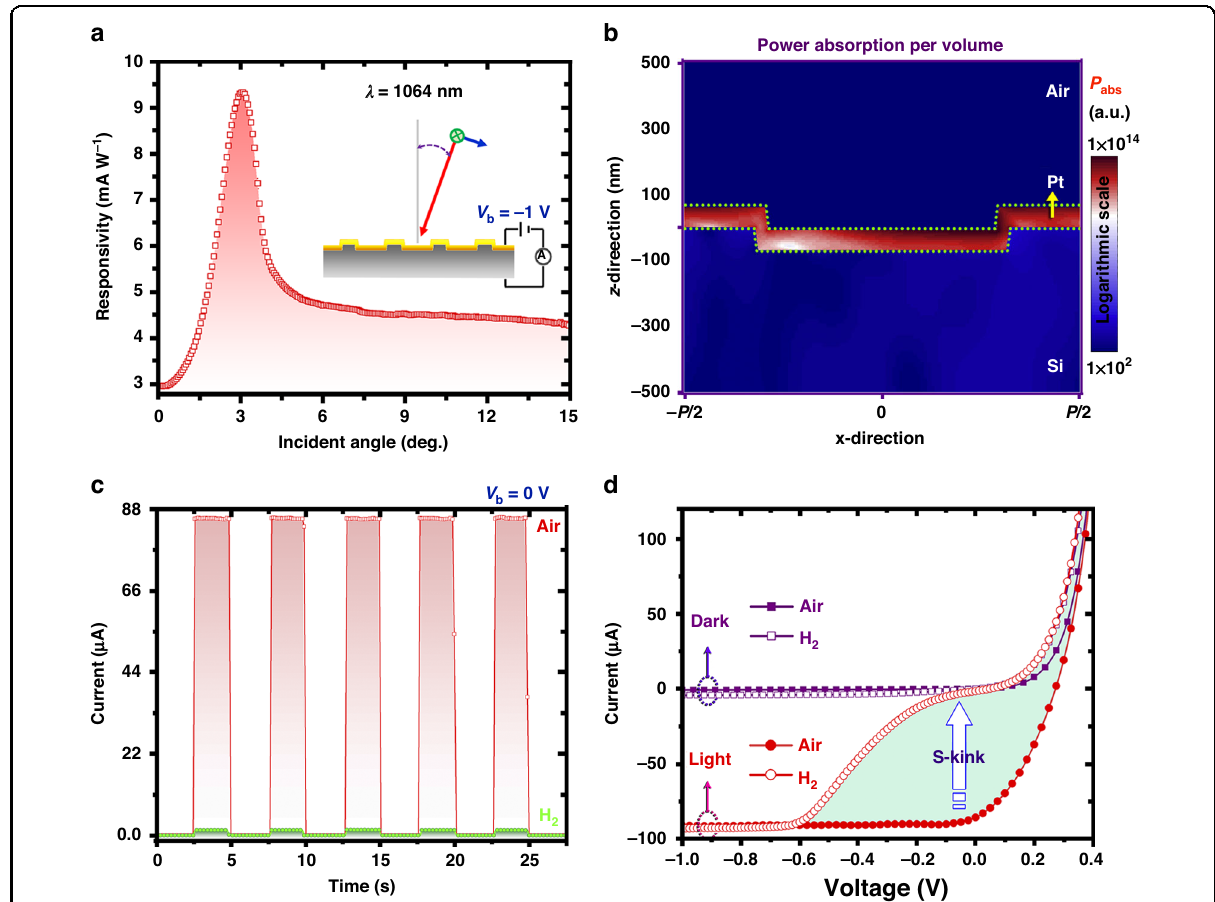
Fig. 2 Hot electron based photoelectric conversion and the hydrogen molecular tailored response. a Angle-dependent photocurrent responsivity of MIS junction with a negative voltage bias ( V b = − 1 V). b Normalized power absorption per unit volume ( P abs , m − 3 ) of the plasmonic structure. c The on-off photocurrent response of the MIS junction ( V b = 0 V) operating under air and H 2 gas states. d The light and dark I – V curves of the plasmonic MIS junction after long-term exposure to air and H